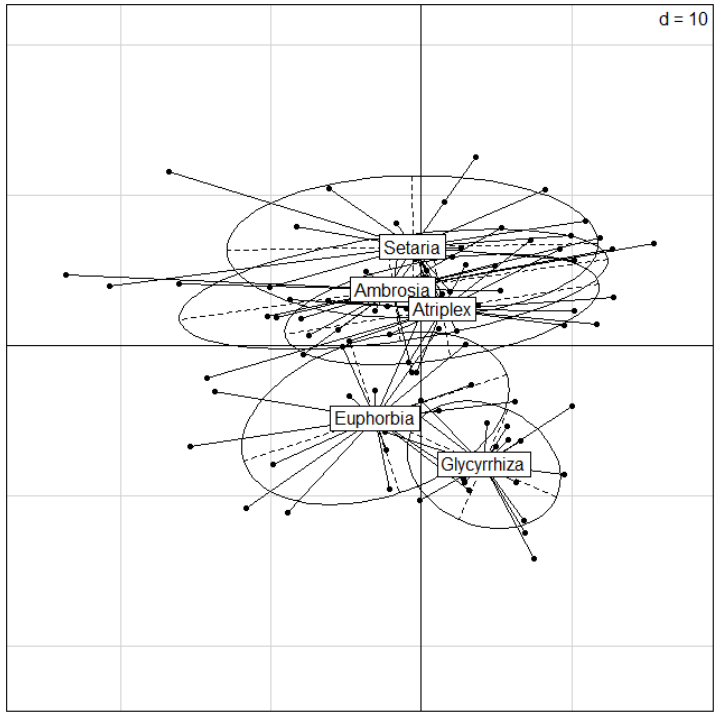
Figure 9. Projection of 100 spectral bands for Ambrosia artemisiifolia , Atriplex tatarica , Glycyrrhiza glabra , Euphorbia seguieriana , and Setaria pumila .